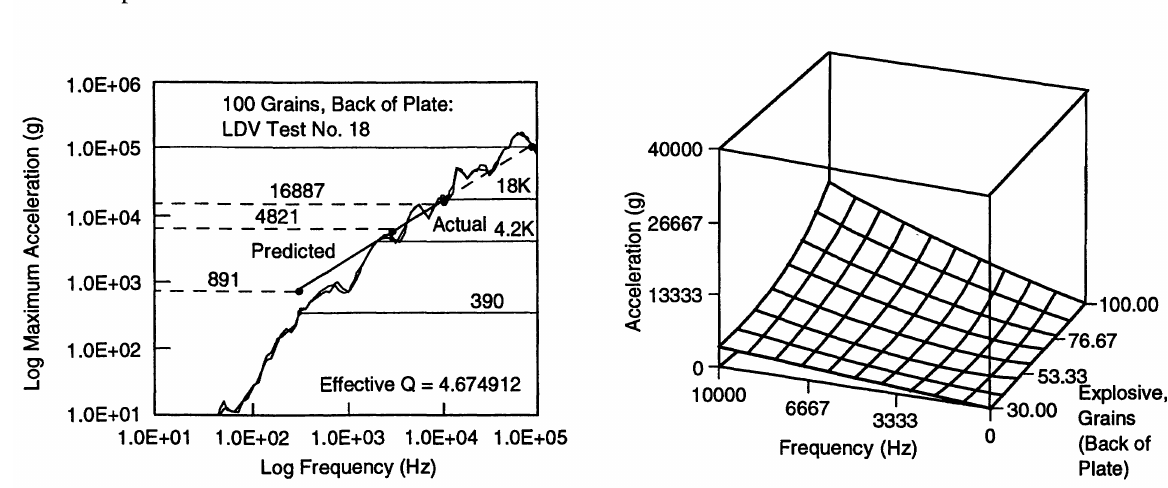
FIGURE 5 LDV SRS plot, comparison of predicted vs. actual maximum g values.